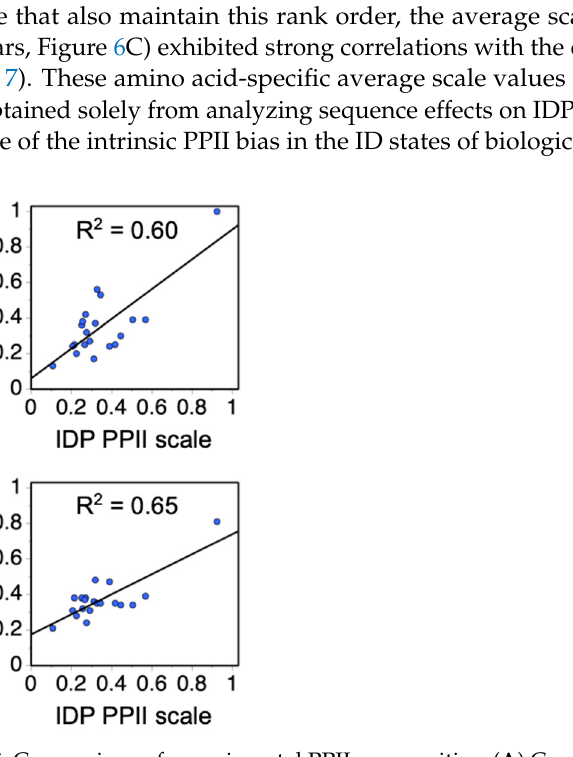
Figure 7. Comparison of experimental PPII propensities. ( A ) Correlation of the peptide-measured PPII scale from Hilser and coworkers (column 4, Table 1) with the IDP-measured PPII propensities (blue bars, Figure 6C). ( B ) Correlation of the coil library (Table 3) and IDP scales. In both plots, each blue circle represents an amino acid type.